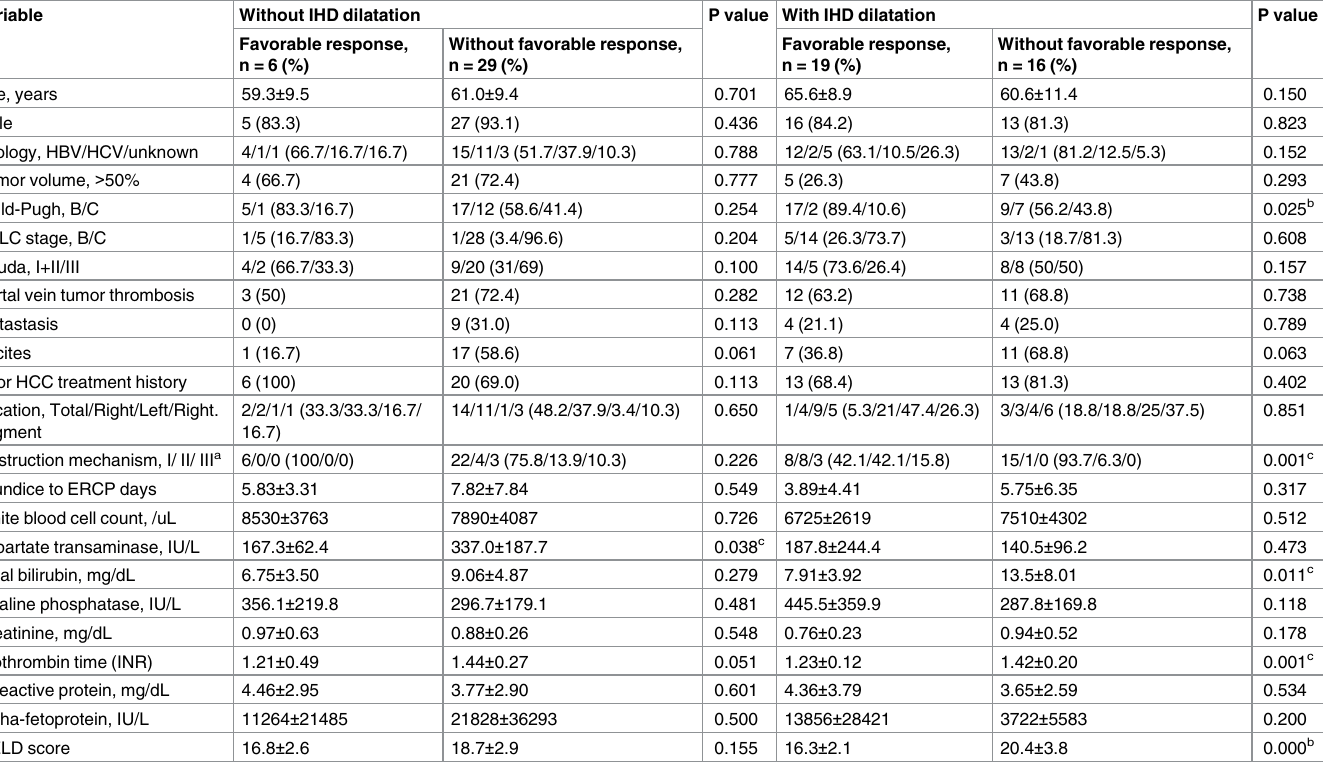
Table 3. Subgroup analysis of clinical factors associatedwith complete response after biliary drainage according to IHD dilatation status.